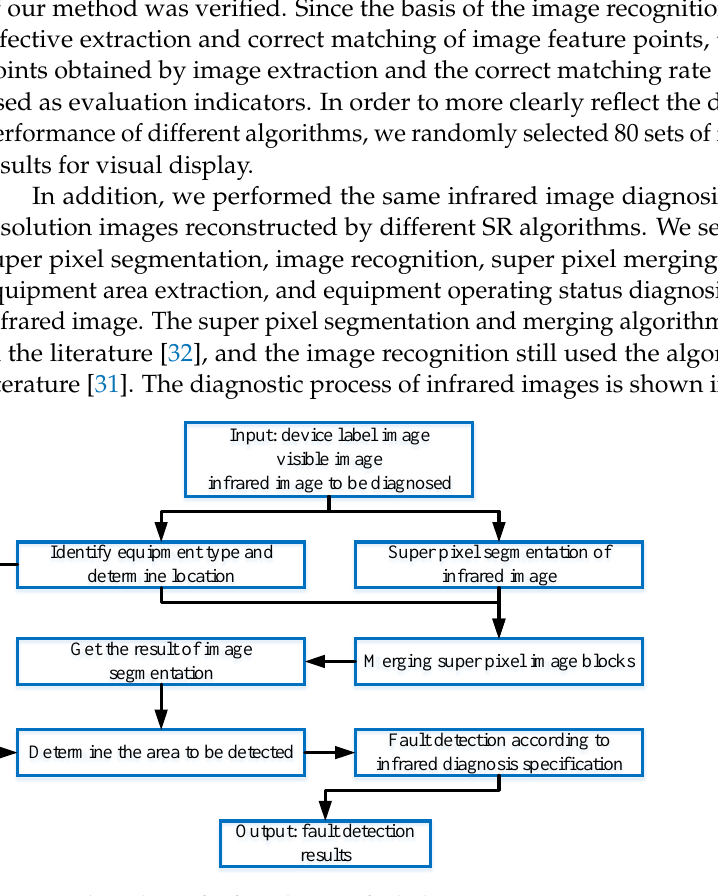
( f ) Figure 5. Different methods to reconstruct the real infrared image of No. 9. ( a ) Real infrared image ( b ) Reconstruction results using the method in [30] (AG = 20.705, IE = 6.222) ( c ) Reconstruction results using the method in [19] (AG = 28.421, IE = 6.323) ( d ) Reconstruction results using the method in [11] (AG = 28.452, IE = 6.362) ( e ) Reconstruction results using the method in [21] (AG = 31.559, IE = 6.429) ( f ) Reconstruction results using our method (AG = 30.784, IE = 6.542). According to Figure 5, the reconstruction result of the method proposed by Keys et al. are the most ambiguous. The image details and textures reconstructed by the methods proposed by Shao and Li are similar. Although they have a significant improvement in visual quality compared to the original low-resolution blurred images, they are still